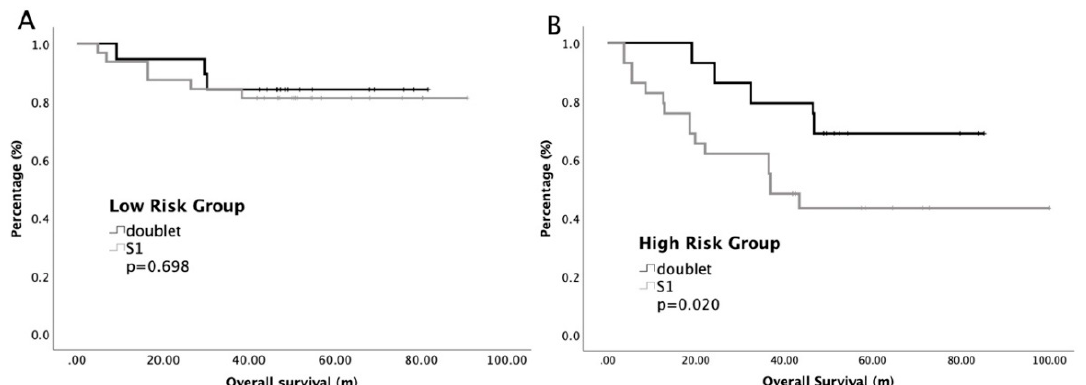
Figure 2. Recurrent-free survival ( A ) and overall survival ( B ) of 128 patients with advanced gastric cancer receiving adjuvant chemotherapy, stratified by low risk or high risk.